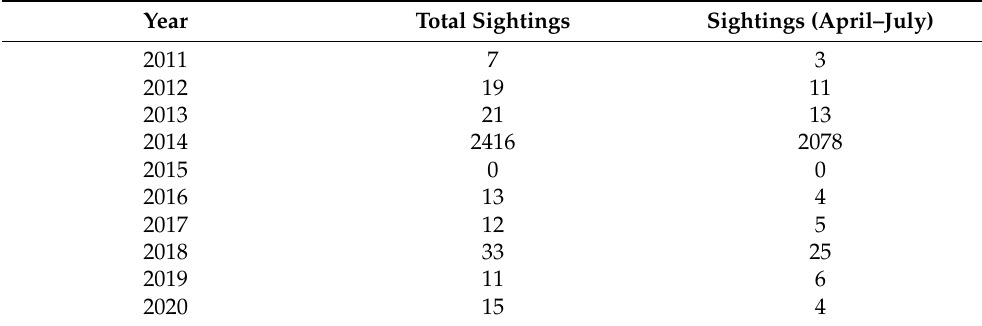
Table 1. L. zampa sightings from 2011 to 2020 for the entire year (January–December) and during the peak emergence season (April–July).